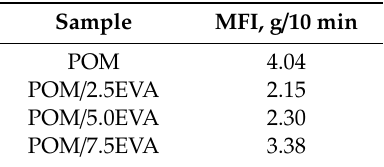
Table 5. Values of the melt flow index for investigated